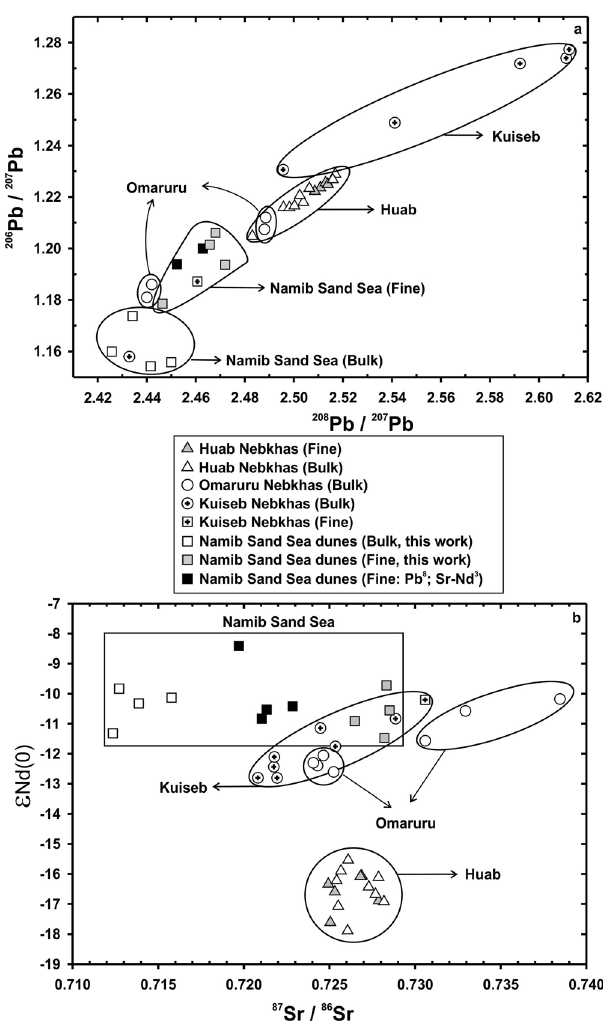
Fig. 2 Rare Earth Elements (REE) data of surface sediments representing the Potential source areas of Southern Africa. a Mean REE patterns. b Relationships between Eu/ ∗ Eu and La/Yb ucc . REE data has been normalized to upper continental crust 44 . Errors bars are smaller than symbols. (Fig. 2a). Note that for the Omaruru catchment only the REE data for three out seven samples are available. Both the bulk and the fi ne fractions from Huab and Kuiseb exhibit Eu/Eu * < 1, with Omaruru displaying slightly higher values (Fig. 2b) for this ratio.